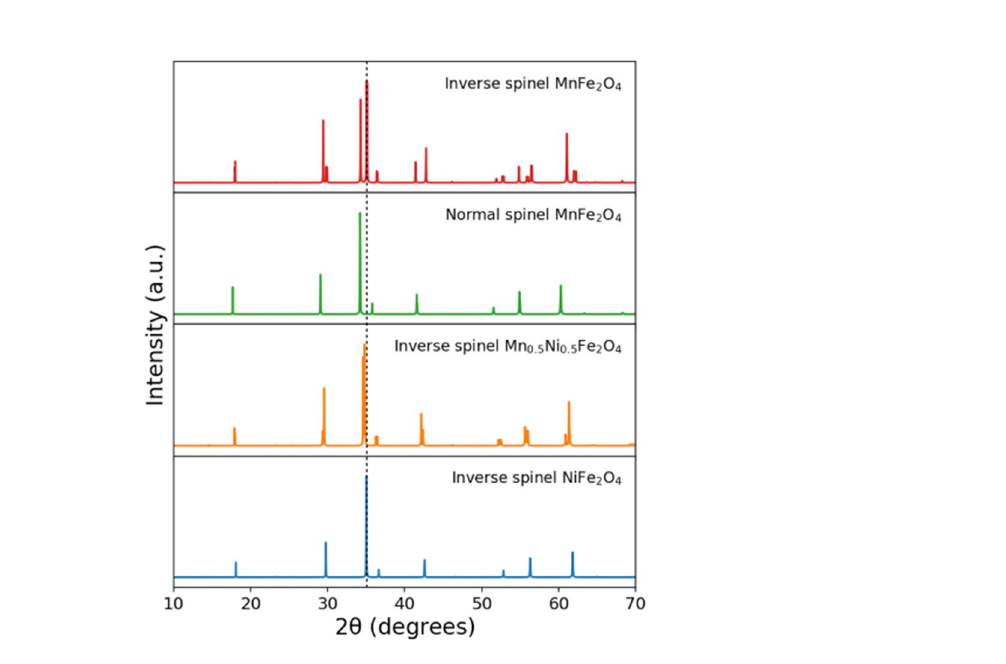
Figure 17. The computed XRD patterns of the crystal structures considered in this